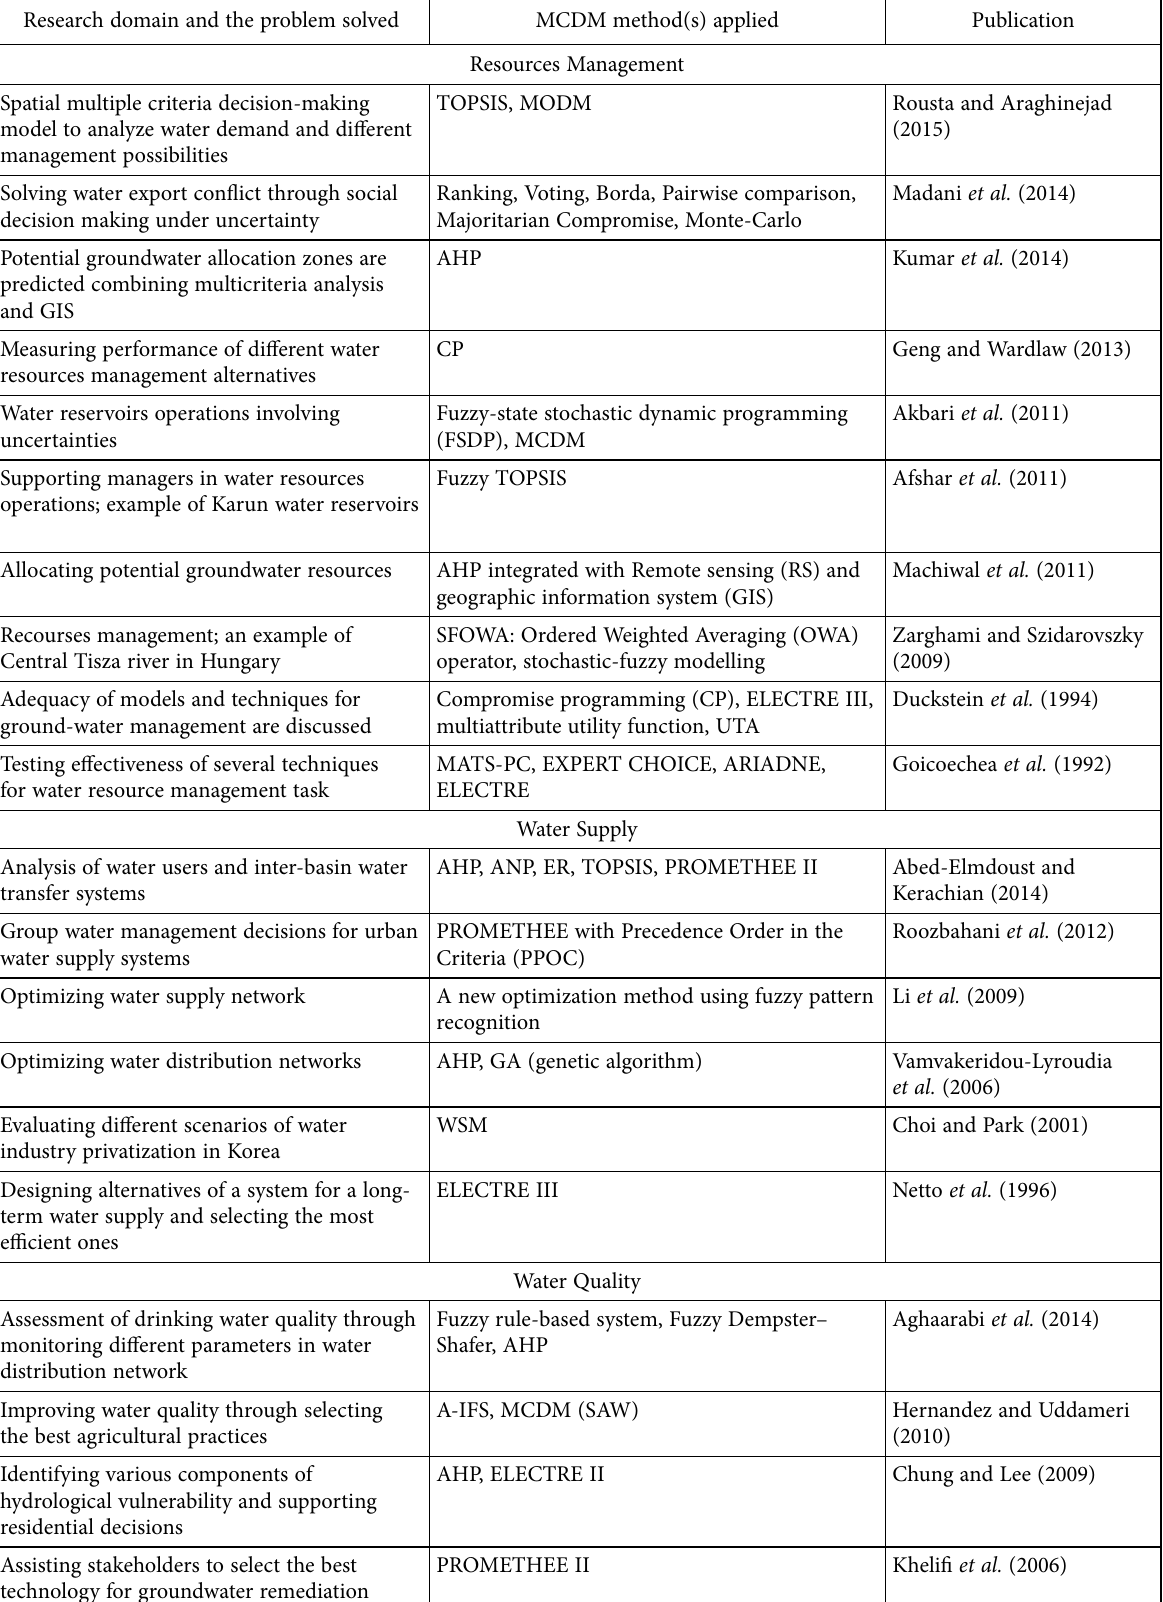
Table 3. MCDM applications by research domains in Water Resources research